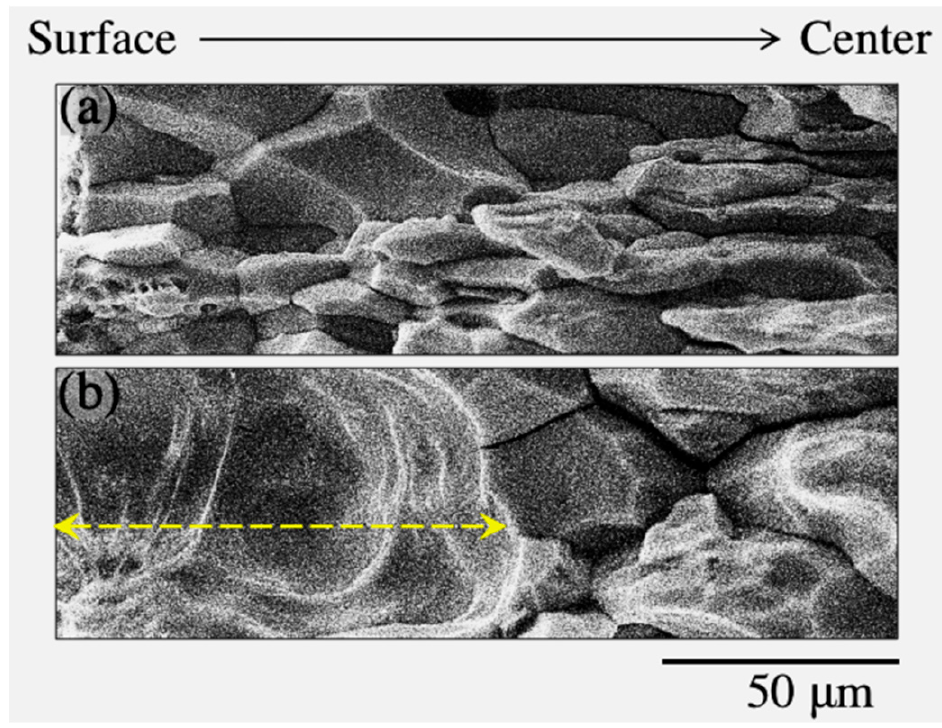
Figure 5. SEM fractography of the specimens which were deformed in humid air; ( a ) unshot-peened, and ( b ) the ultrasonic shot-peened specimens. The yellow arrow indicates the width of the transgranular fracture.